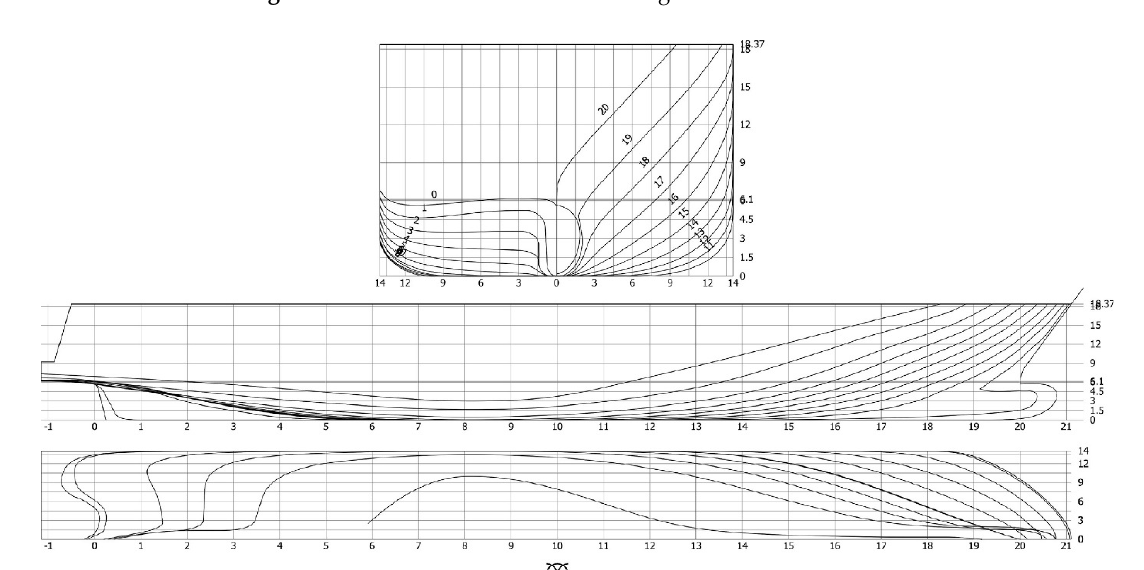
Figure 3. Bare hull lines drawing of the studied RoPax ship